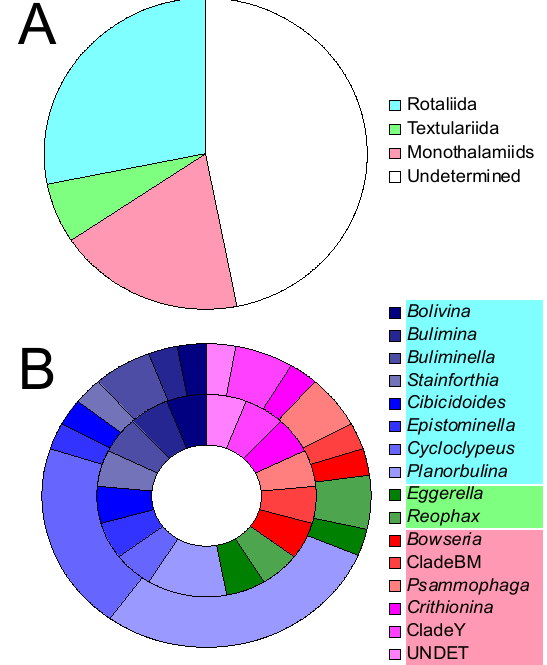
Fig. 4. Taxonomic composition of the foraminiferal ribosomal RNA OTUs (operational taxonomy units) clustered at 96% sequence identity from the top centimeter of the sediment in the “10 months” chamber. (A) Relative proportions of the 32OTUs identified to the order level or left unassigned after taxonomic assignment based on Needleman-Wunsch global alignments of the 37f hypervariable re- gion as in Lejzerowicz et al. (2013). (B) Relative proportion of OTUs (inner circle) and sequences (outer circle) assigned to the genus